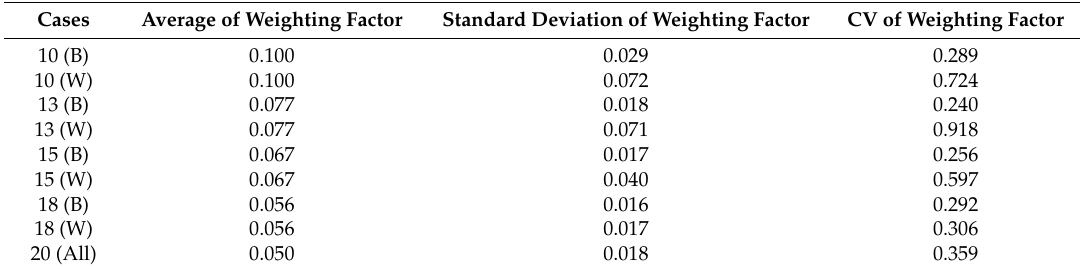
Table 10. Basic statistics of Thiessen Weighting Factors for AAR Estimation.